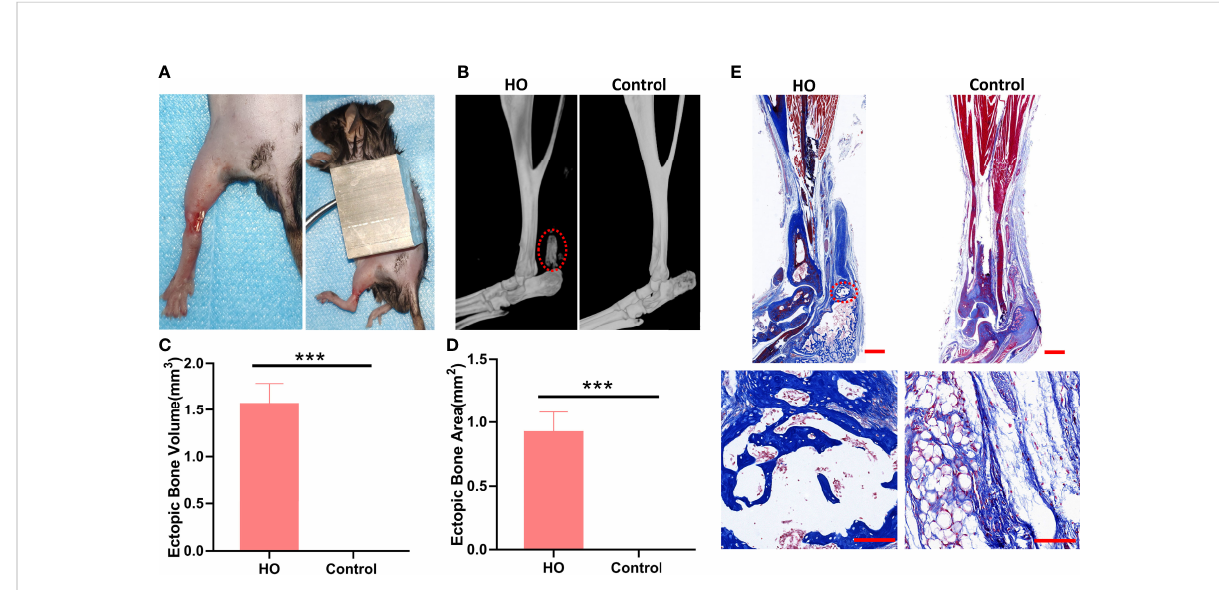
FIGURE 2 Identi fi cation of the HO model. (A) Surgical procedures for induced traumatic HO by Achilles tenotomy and burn injury. (B) Micro-CT reconstruction images of Achilles tendon (red circle) in HO and control groups 9 weeks after surgery. (C) Micro-CT quanti fi cations of ectopic bone volume in the injury sites (n = 4). (D) Masson staining of Achilles tendon in each group 9 weeks after surgery. The ectopic bone appears dark blue (red circle), while the tendon appears light blue. Original magni fi cation: ×1 (top row); ×20 (bottom row). (E) Histomorphometric quanti fi cations of ectopic bone areas in the injury sites (n = 4). *** indicates that p < 0.001.